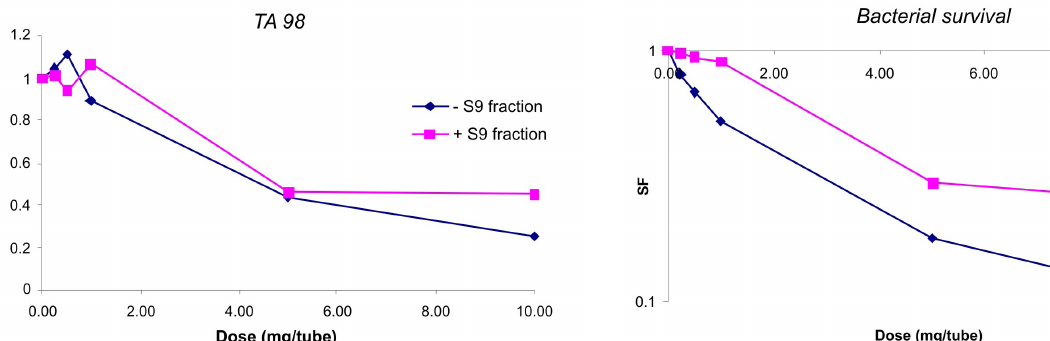
FIGURE 5 - Survival Fraction (SF) as a function of dose (mg/ tube) of “barbatimão” extract (BE) on S. typhimurium TA98 and E. coli WP2s( l ). The maximum coefficient of variation (CV) of experiments was 10%. Plots represent the mean of four independent experiments.